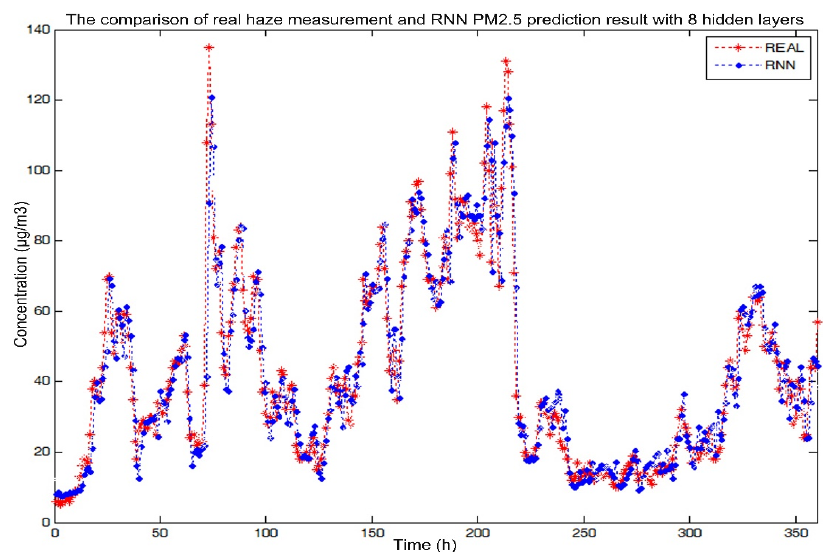
Figure 6. PM2.5 prediction results of 8 hidden layers of RNN network.